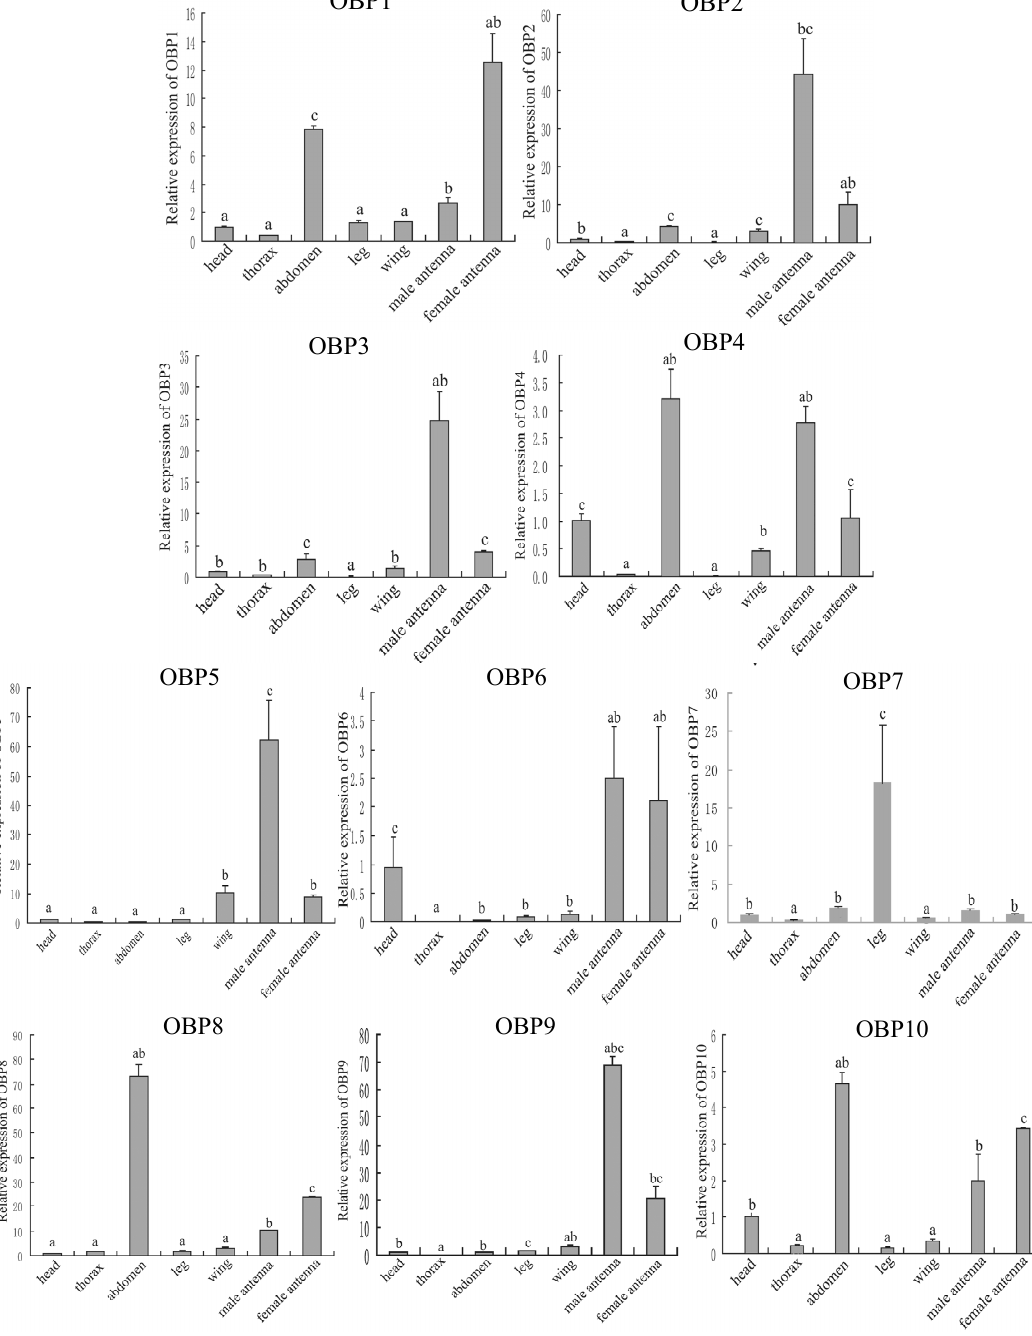
Figure 4. Tissue distribution of the ten identified OBPs . qRT-PCR to analyze OBP transcript levels in different tissues of mature adults during the oviposition period, including head, thorax, abdomen, leg, wing, male antennae, and female antennae. Relative transcript levels are calculated using β -actin as the standard. Different letters indicate significant differences in the expression level of OBPs ( p < 0.05, Duncan’s test). Three biological replicates were performed. OBP1 OBP2